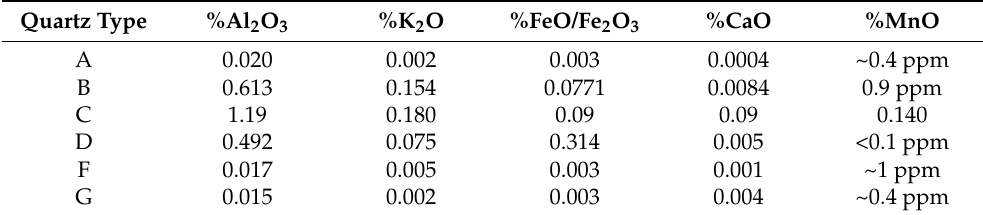
Figure 1. Pictures of the quartz types used in this study: ( A , B , C , D , F , G ), used as raw material in Si and FeSi production. Table 1. ICP-MS analyses for quartz type A, B, C, D, F and G [18,21], used as raw material in Si and FeSi production.